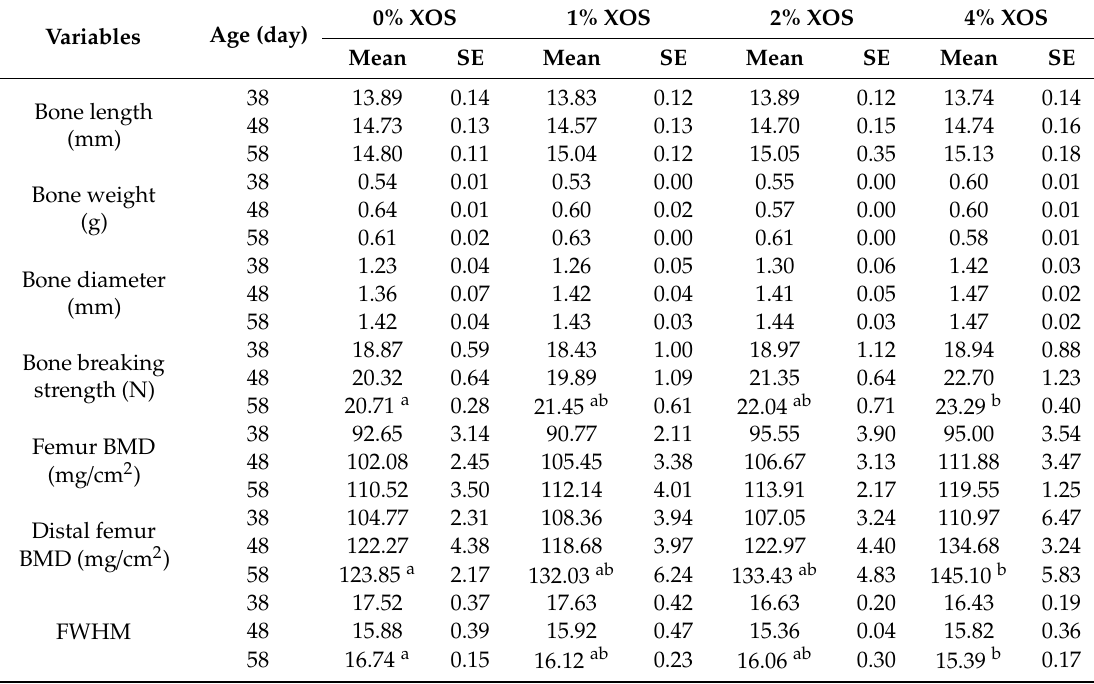
Table 3. Femoral parameters, mineral density, breaking strength, and FWHM of 960 / cm peak of 38, 48, and 58-d mice fed di ff erent levels of XOS (Mean values and standard errors; n = 8 in each group).